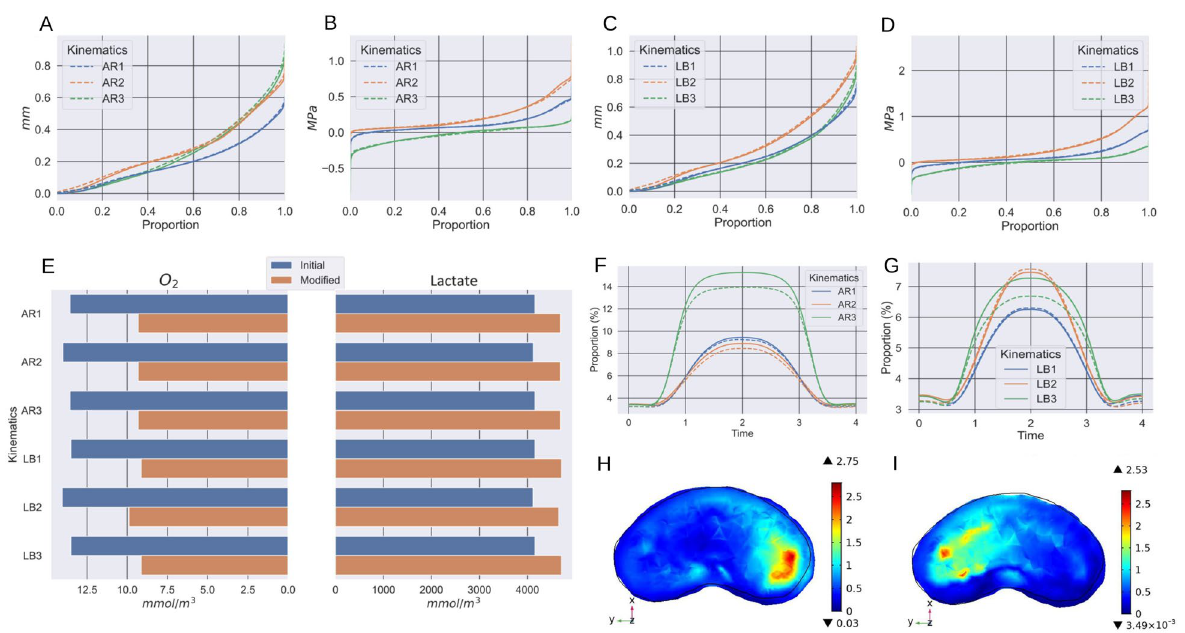
Figure 4. (A–D) Empirical cumulative distribution functions of the displacement ( A,C ) and IDP fields ( B,D ). Solid line: initial geometry; dashed line: modified geometry. E: Critical nutrients concentration at t = 2 s for the initial (blue) and modified (orange) geometry. ( F,G ) Proportion of the anisotropic strain energy with respect to the total strain energy over time during LB ( F ) and AR ( G ). ( H,I ) Ratio of the first eigenvalue of PK aniso over the first eigenvalue of PK iso at t = 2 s during AR1 ( H ) and AR3 ( I